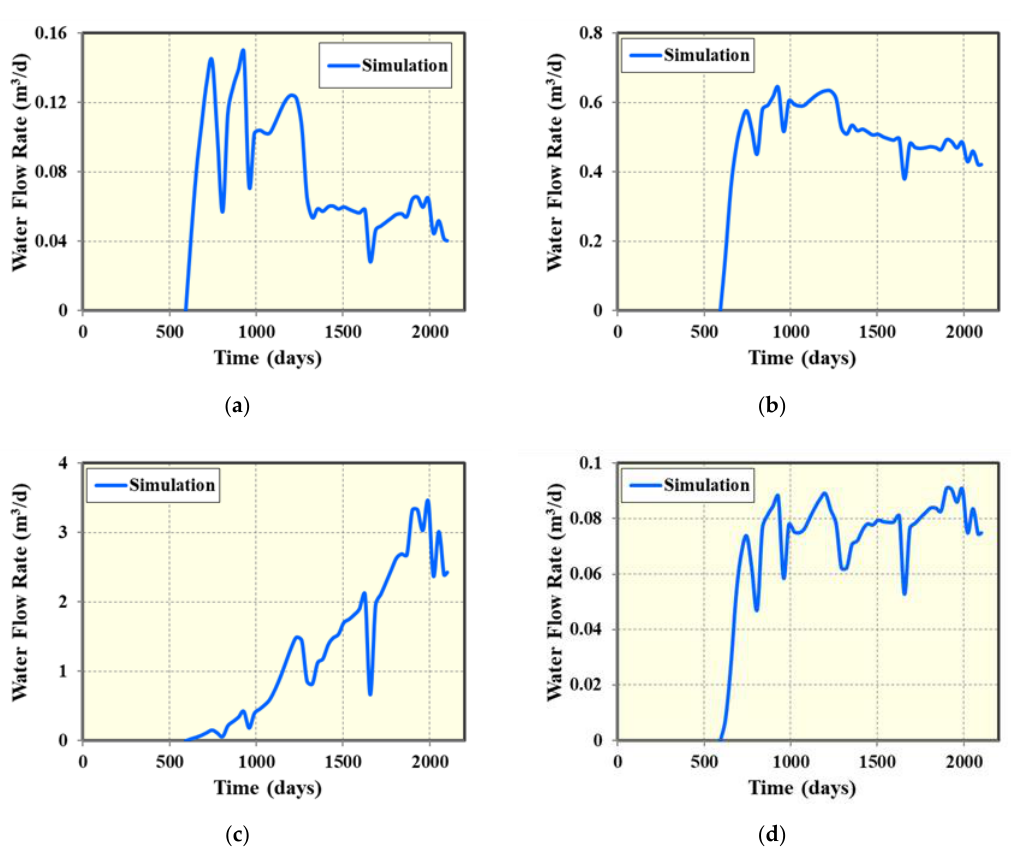
Figure 24. Different water intrusion responses from four different paths to well B3: ( a ) water rate from shortest path 1; ( b ) water rate from shortest path 2; ( c ) water rate from shortest path 3; ( d ) water rate from shortest path 4.